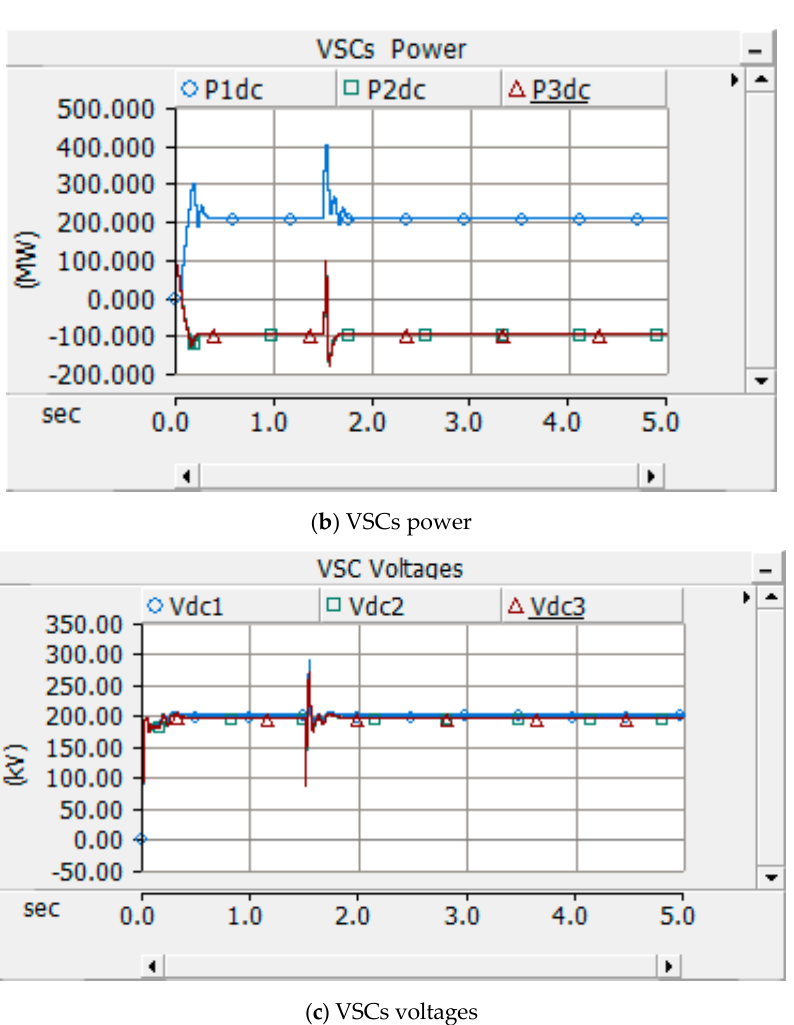
Figure 11. Three-phase to ground fault at the middle of the transmission line for 0.03 s duration.